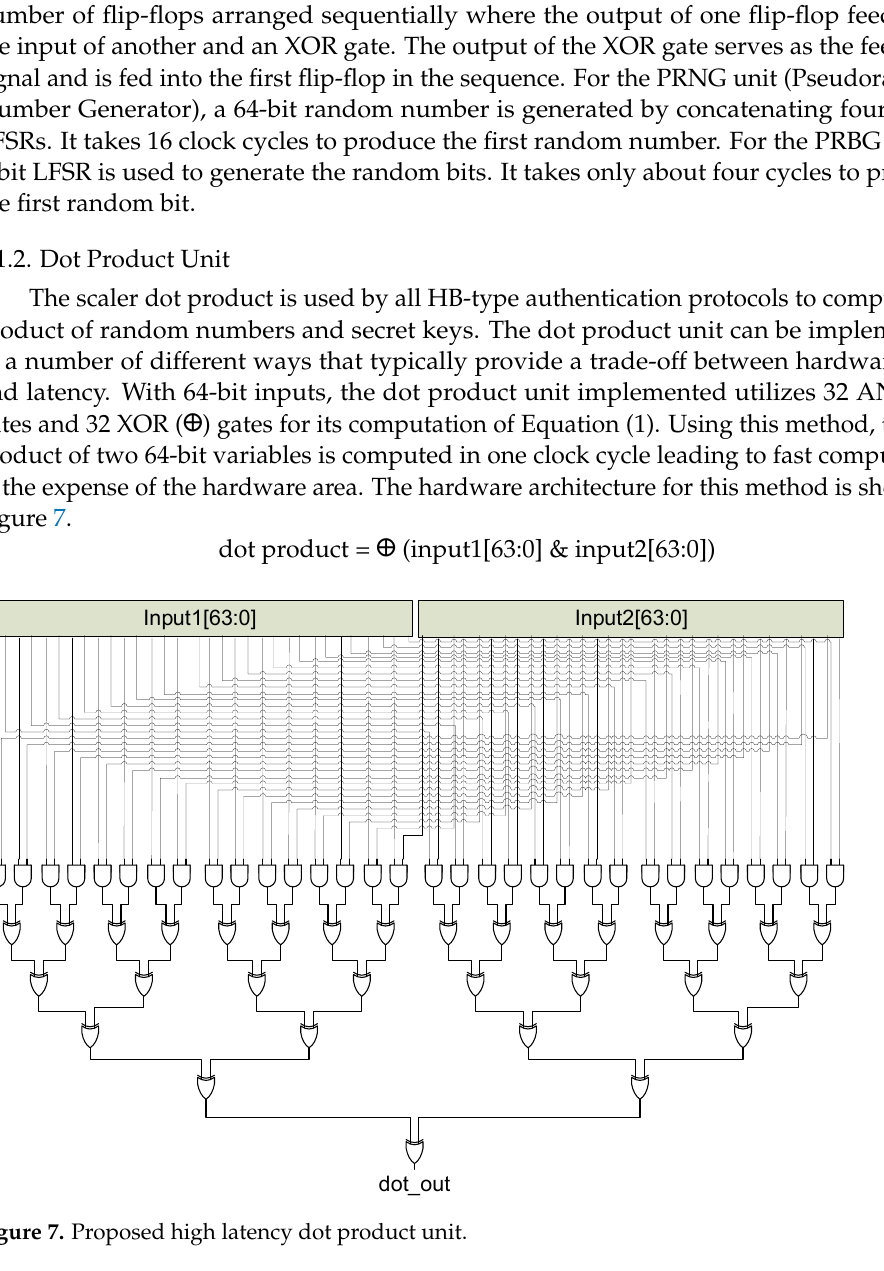
Figure 7. Proposed high latency dot product unit.